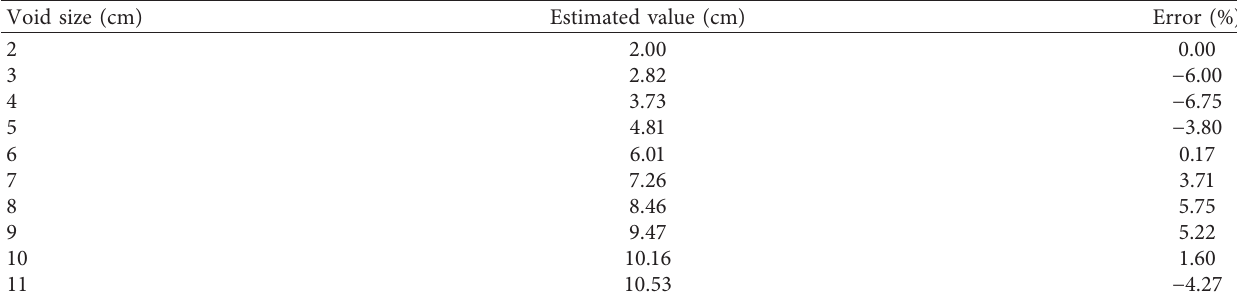
Table 3: Void-size determination errors of the